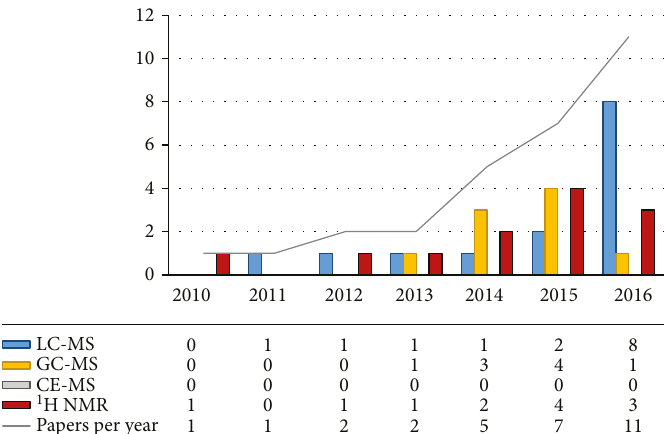
Figure 1: Summary of published